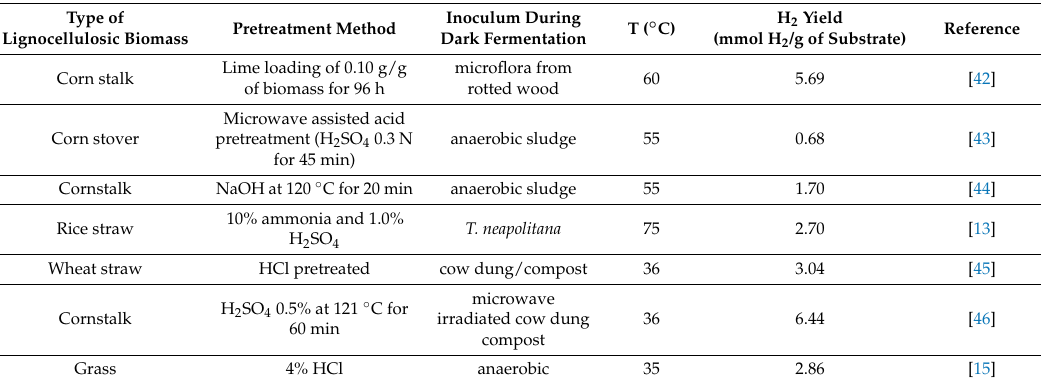
Table 2. Hydrogen yield obtained during fermentation of lignocellulosic hydrolysates after different pre-treatment